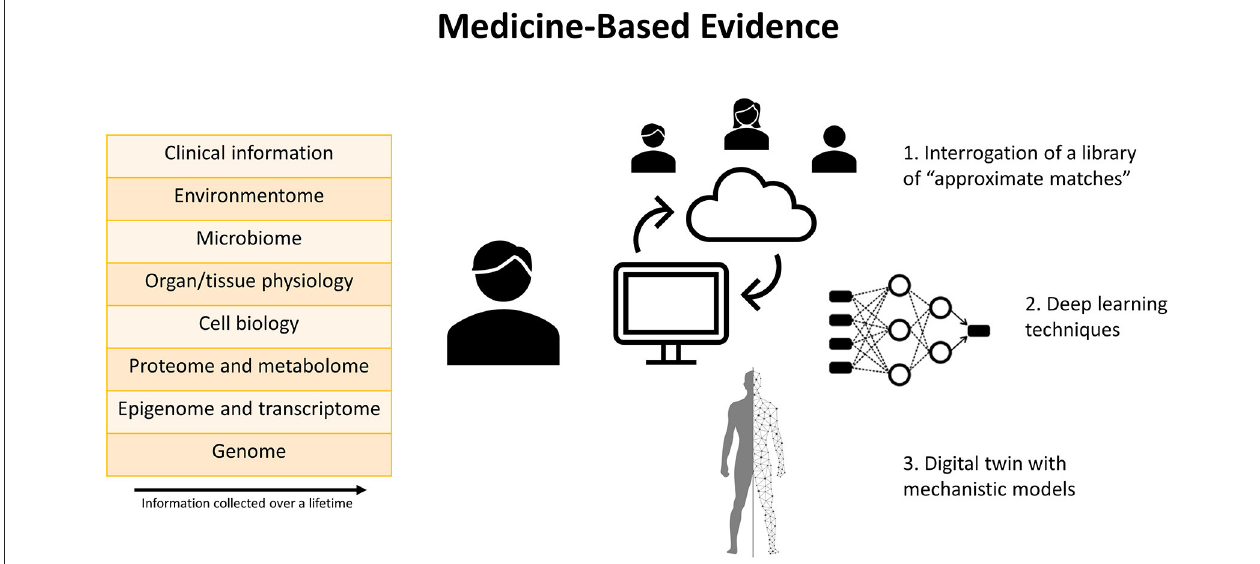
FIGURE 1 | Graphical summary of the concept of Medicine-Based Evidence. Comprehensive profiling of each patient is performed based on data collected over a lifetime. Several tools are available to facilitate individualized decision-making based on these data. First, a library of “approximate matches,” consisting of a group of patients who share greatest similarity with the index case, can be interrogated to estimate the effects of various treatments within the context of the individual patient’s specific characteristics. Second, deep learning techniques can detect patterns in experimental and clinical datasets from different sources. Third, a “digital twin” which incorporates mechanistic models can generate patient-level predictions according to the laws of physiology, physics, and